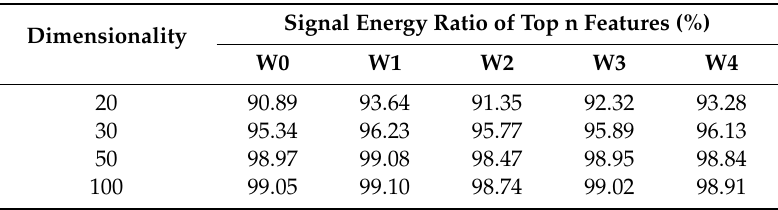
Table 4. The energy ratio of extracted feature dimensionalities.